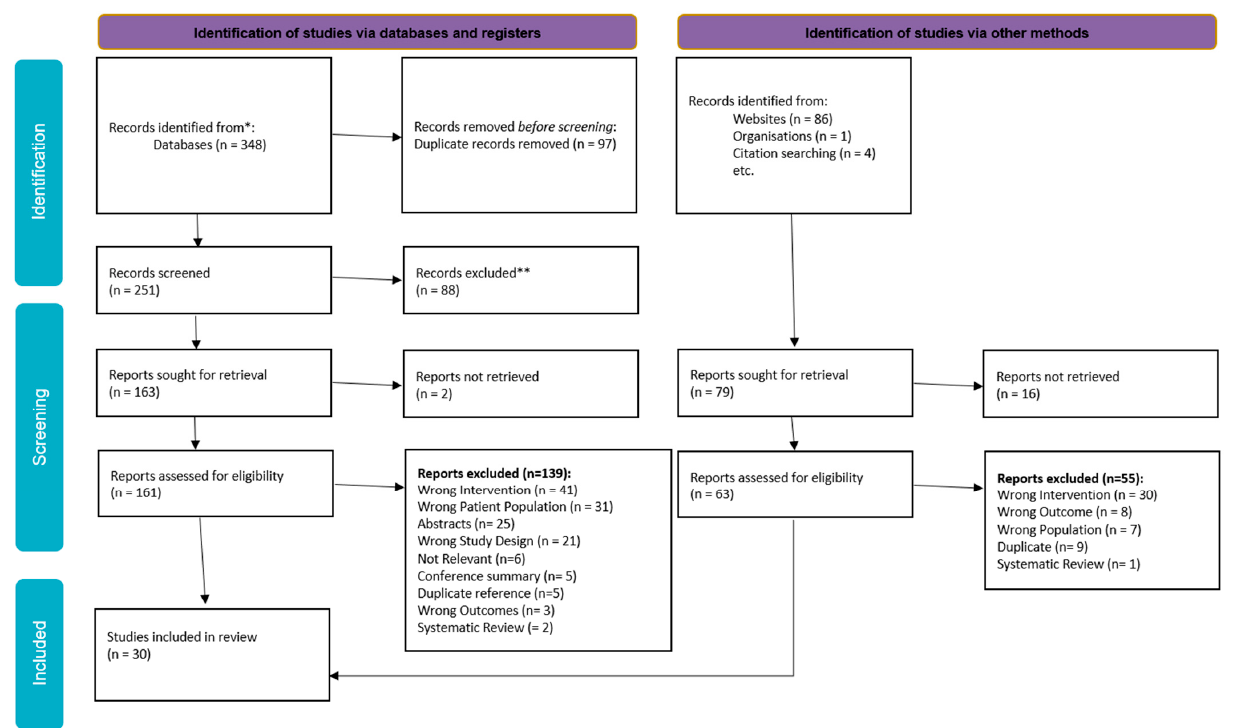
Figure 2. PRISMA Flow diagram.